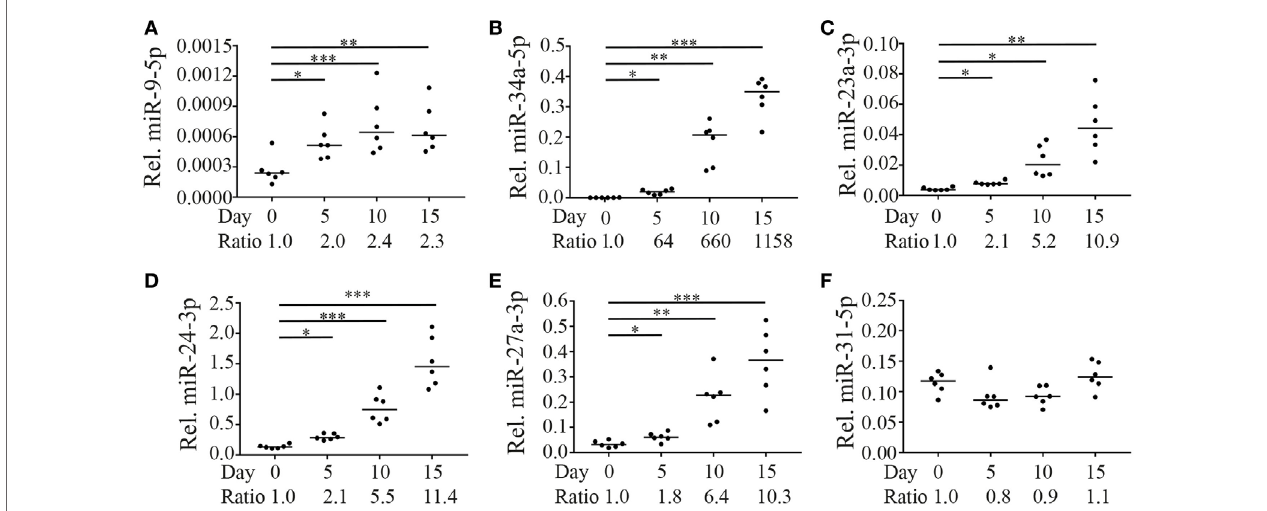
FigUre 4 | Expression of miR-9-5p, miR-34a-5p, and miR-23a~24-2 cluster in CD8 + naive T cells is regulated by IL-15. Fluorescence-activated cell sorting-sorted naive CD8 + CD45RO − CCR7 + CD28 + T cells were cultured in the presence of IL-15 (50 ng/ml). Directly after sorting and after 5, 10, and 15 days of culture, expression levels of (a) miR-9-5p, (B) miR-34a-5p, (c) miR-23a-3p, (D) miR-24-3p, (e) miR-27a-3p (all three part of the miR-23a~24-2 cluster), and (F) as a non-IL-15-responsive control, miR-31-5p were assessed by RT-qPCR. Expression levels of the microRNAs (miRNAs) relative to the expression of RNU44 are shown. Significance (* p < 0.05, ** p < 0.01, *** p < 0.001) is depicted. N =